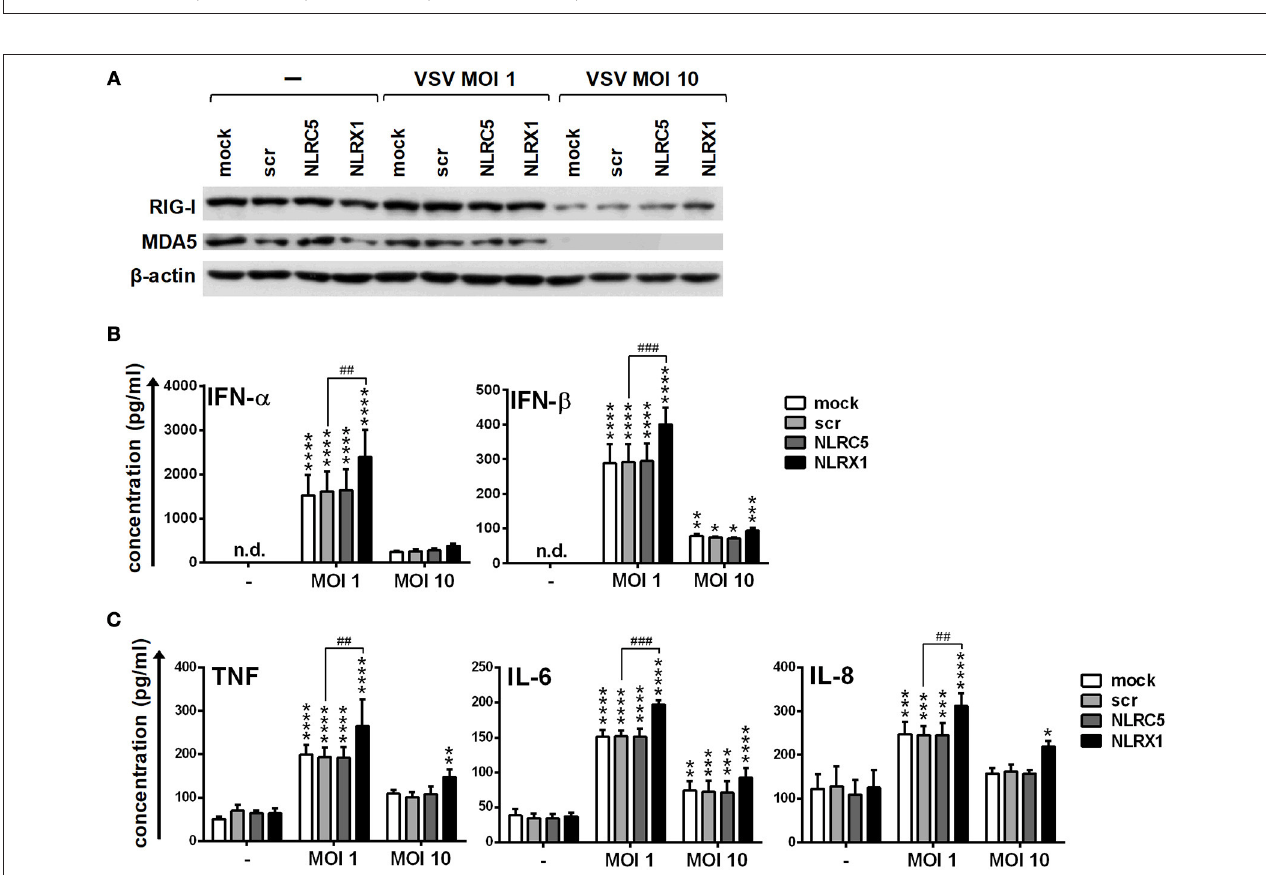
FIGURE 10 | NLRX1 but not NLRC5 affects the type I IFN and pro-inflammatory responses in VSV-infected human moDCs. (A–C) moDCs transfected with the indicated siRNAs were exposed to VSV at the indicated MOIs and after 18h the protein levels of RIG-I and MDA5 (A) were analyzed by western blotting, and the concentrations of secreted IFN- α , IFN- β (B) , TNF, IL-6, and IL-8 (C) were determined by ELISA. (A) A representative blot is shown. (B,C) Data are shown as mean ± SD from 4 independent experiments and analyzed using one-way ANOVA followed by Bonferroni’s post-hoc test. * p < 0.05, ** p < 0.01, *** p < 0.01 **** p < 0.0001 vs. untreated; ## p < 0.01, ### p < 0.001, n.d., not